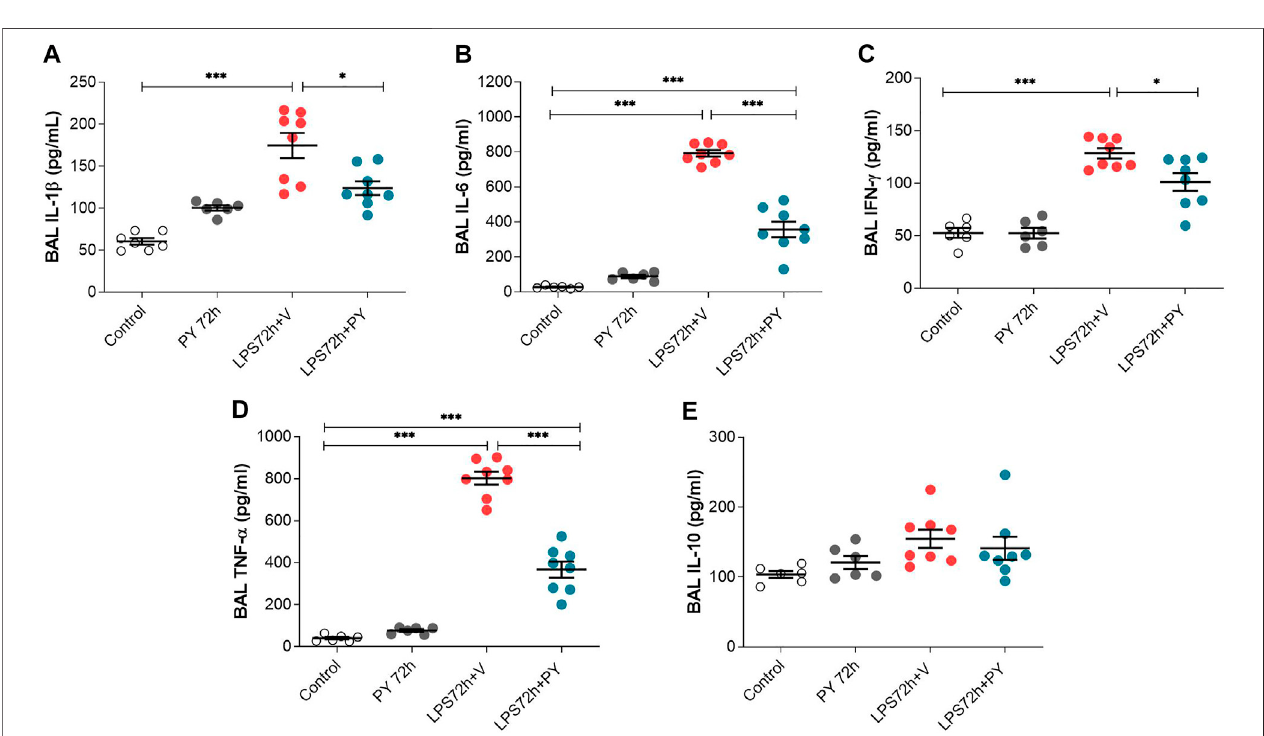
FIGURE6| PyridostigminesuppressesBALpro-in fl ammatorycytokinelevelsinLPSexposedmiceat72 h. (A) IL-1 β (B) IL-6, (C) IFN- γ , (D) TNF- α , (E) IL-10.*** p < 0.001and* p < 0.05.Vehicle(V)group(Control),pyiridostigmine(PY),lipopolysaccharide(LPS).Valuesexpressedasmean ± SEM.One-wayANOVAfollowedbyTukey ’ s test (See text for